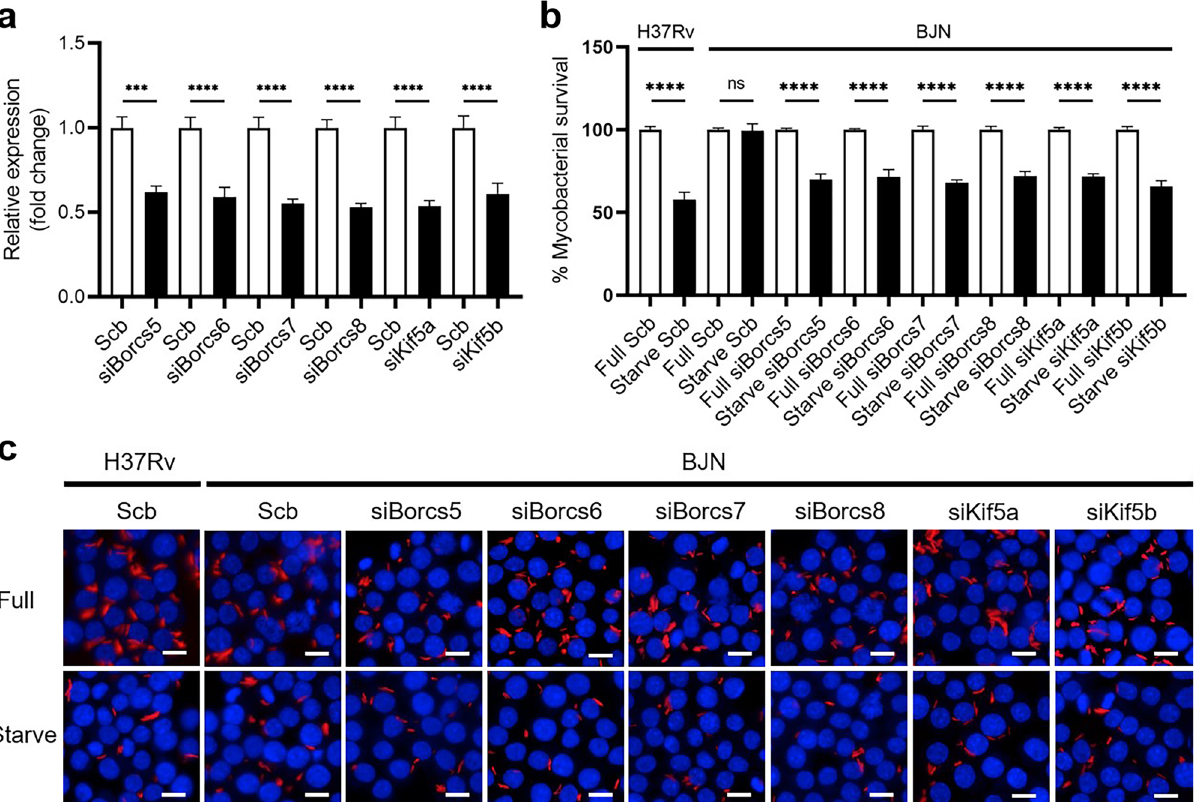
Figure 1. BORCS5-8 and Kinesin-1 are important for the evasion of autophagic restriction by the BJN in RAW264.7 macrophages. ( a ) RAW264.7 macrophages were transfected with siRNAs against Borcs5 , Borcs6 , Borcs7 , Borcs8 , Kif5A , and Kif5B or scrambled control siRNAs by nucleofection for 48 h. Knockdown efficiency was determined by qRT-PCR. Expression levels of the target genes were normalised to that of the housekeeping gene, Gapdh . Data are means ± SEM from at least three independent experiments; ***p < 0.001 and ****p < 0.0001, relative to the scrambled siRNA control set to 1.0 determined by one-way ANOVA with Tukey’s multiple comparison test. ( b,c ) RAW264.7 macrophages deficient in BORC5-8 and Kinesin-1 were infected with mCherry-expressing H37Rv or BJN (MOI = 10) for 1 h followed by autophagy induction by starvation for 4 h. The number of intracellular mycobacteria per cell was then determined by high-content imaging, and percent of mycobacterial survival was calculated and compared ( b ). Data are means ± SEM from at least three independent experiments; ns non-significant and ****p < 0.0001, all relative to the full control set of 100% determined by one- way ANOVA with Tukey’s multiple comparison test. Representative images are displayed in ( c ). Bar 10